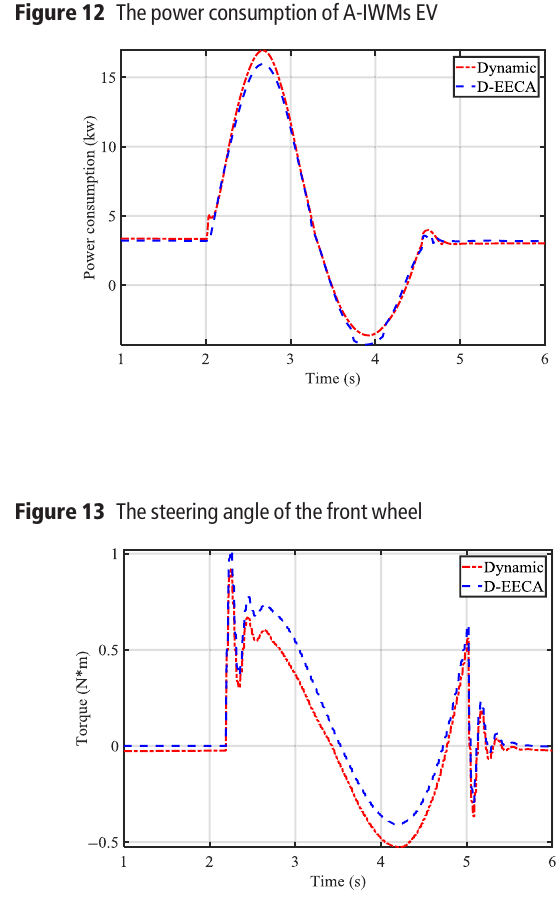
Figure 12 The power consumption of A-IWMs EV